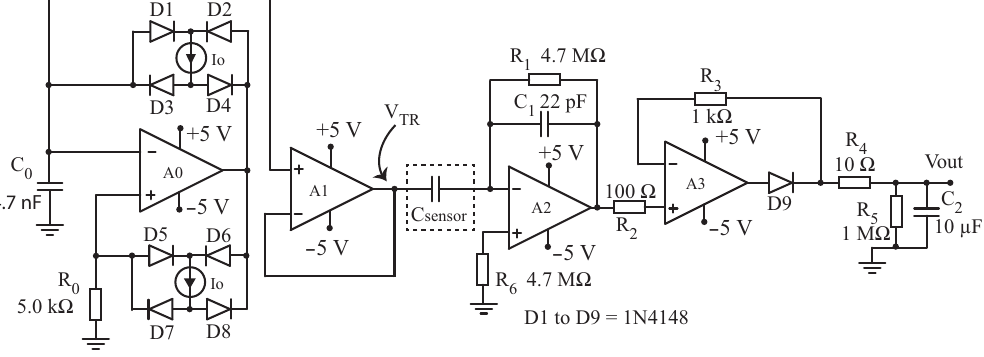
Figure 4. Schematic diagram of the signal conditioning